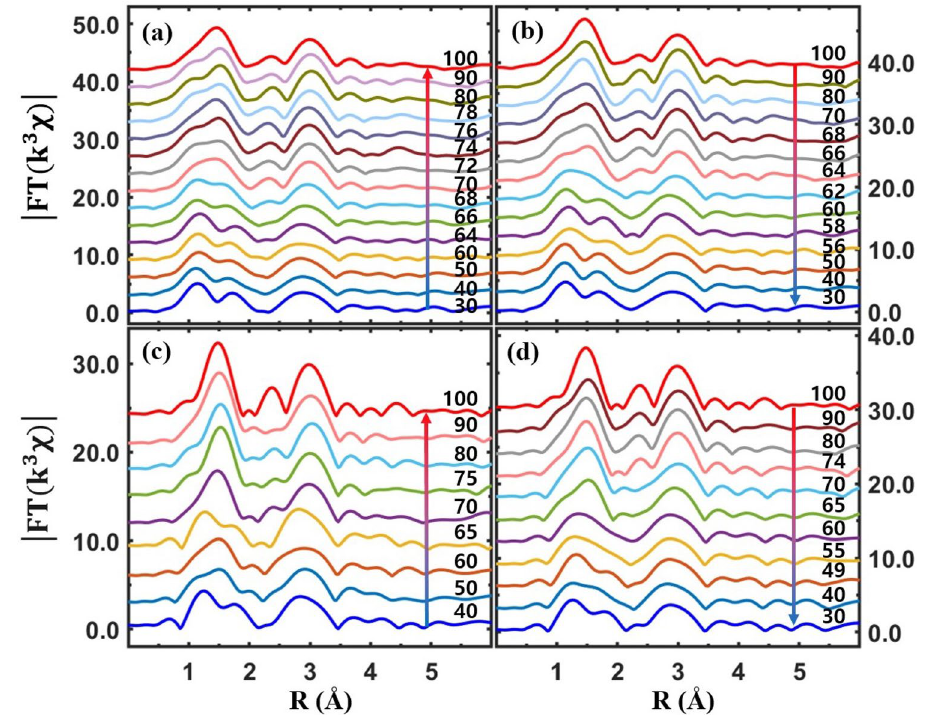
Figure 7. Magnitude of Fourier transformed EXAFS (|FT(k 3 χ )|) as a function of the distance from a V atom at different temperatures. ( a , b ) EXAFS from pristine VO 2 for heating and cooling, respectively. ( c , d ) EXAFS from Cr-VO 2 with a Cr ion energy of 50 keV and a flux of 10 12 ions/cm 2 for heating and cooling, respectively. The data are vertically shifted for